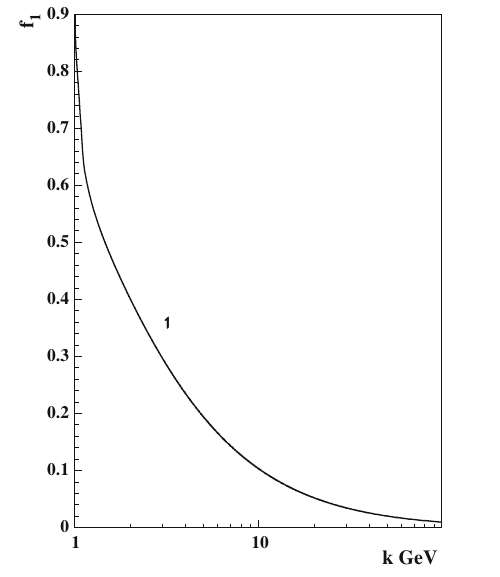
Fig. 15 Momentum distribution of a state similar to the real ground state, with k c = 1 . 05 GeV, ω = 0 . 37 and η = − 2 . 35